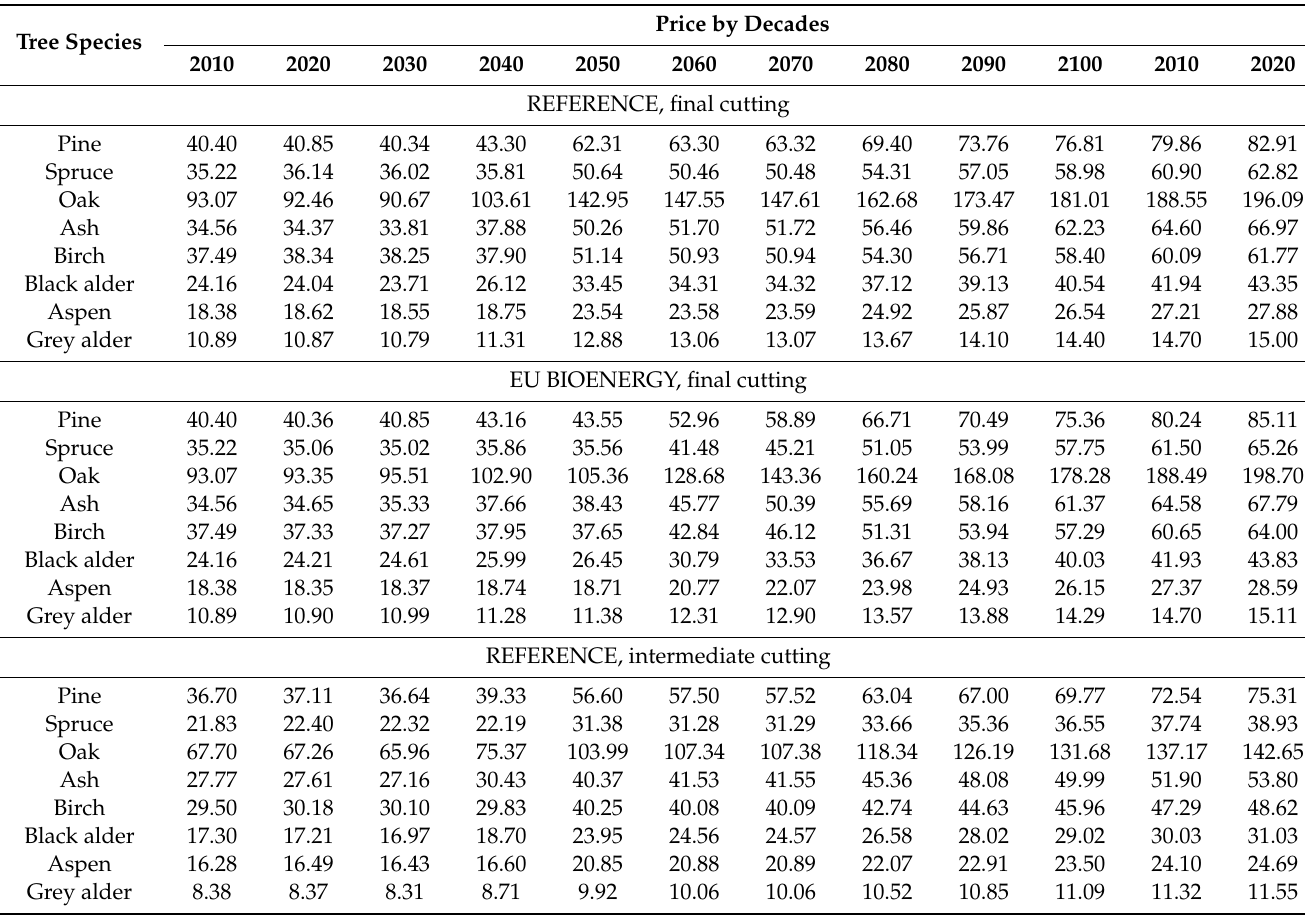
Table A3. Average timber price (in Eur / m 3 ) by tree species, IIASA scenarios, and cutting type during the simulation period. Tree